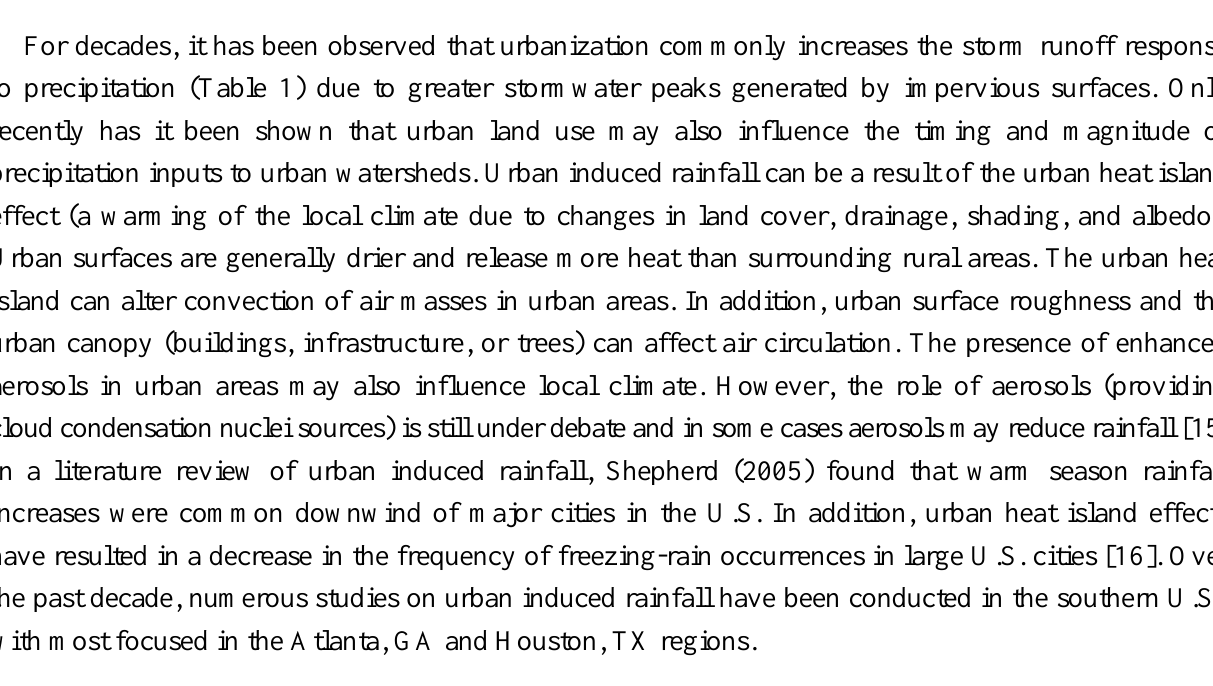
Table 1. Hydrologic responses to urbanization documented in the southern